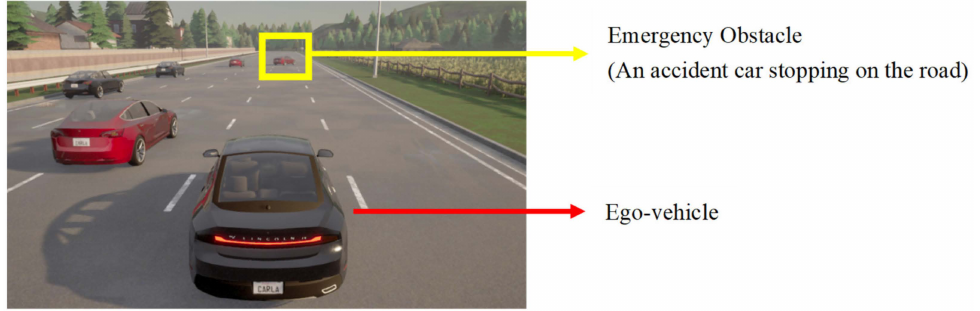
Figure 3. Emergency obstacle avoidance simulation